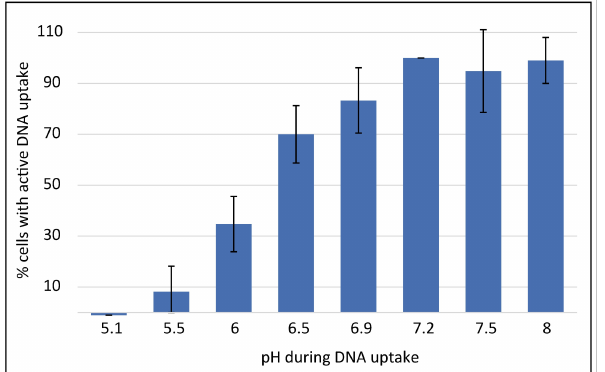
Figure 6. DNA uptake is completely shut down at slightly acidic pH. Competent C. jejuni BfR- CA-14430 bacteria were incubated with fluorescently labelled DNA in BHI titrated to the indicated pH values ( ± 0.1) under microaerobic conditions. The fraction of bacteria showing active DNA uptake are depicted, normalized to untitrated BHI, pH 7.2 condition (set to 100%). Experiments were performed at least three times with independent cultures. Error bars indicate standard deviation. BHI, brain-heart